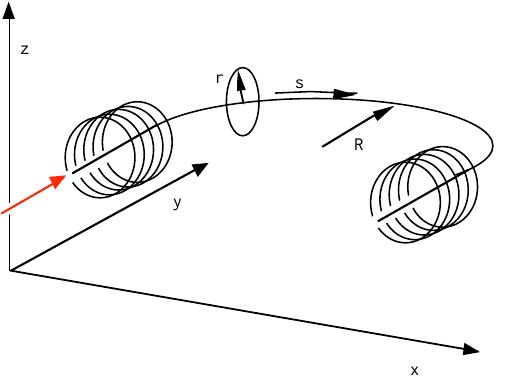
FIG. 1. (Color) The parameters of a bend which has two straight sections and no coupling sections, in Cartesian coor- dinates.